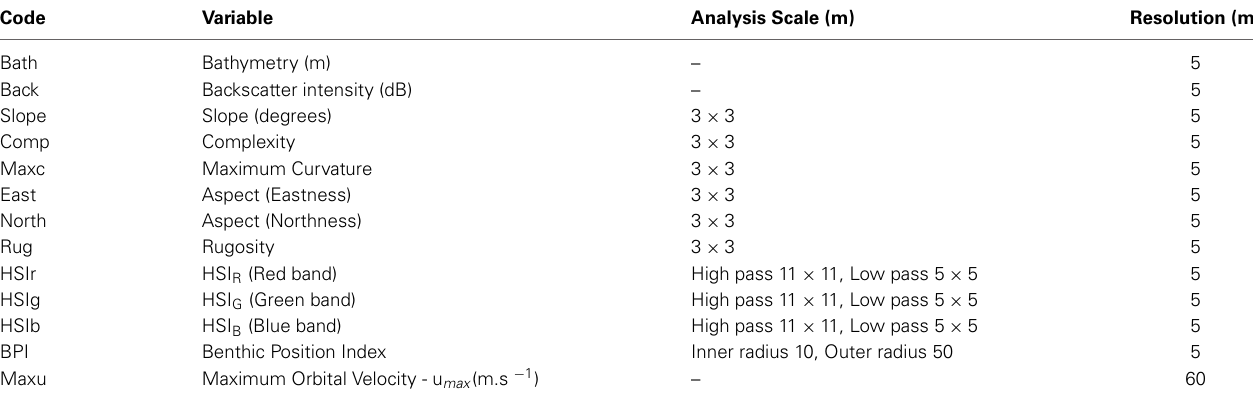
Table 1 | Environmental predictor variables used to inform the Random Forests models.